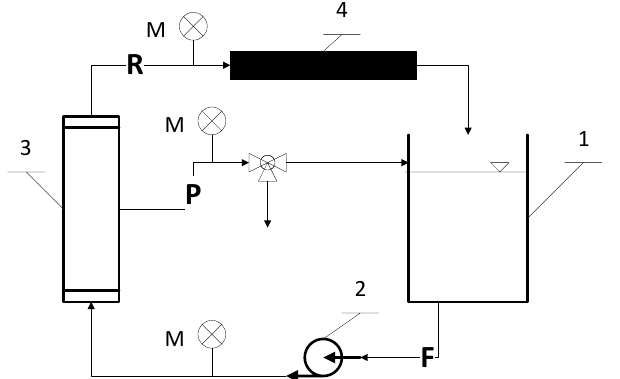
Figure 1. Schema of the laboratory plant: 1—feed / retentate tank; 2—pump; 3—membrane module; 4—radiator; F—feed; R—retentate; P—permeate; M—manometer.